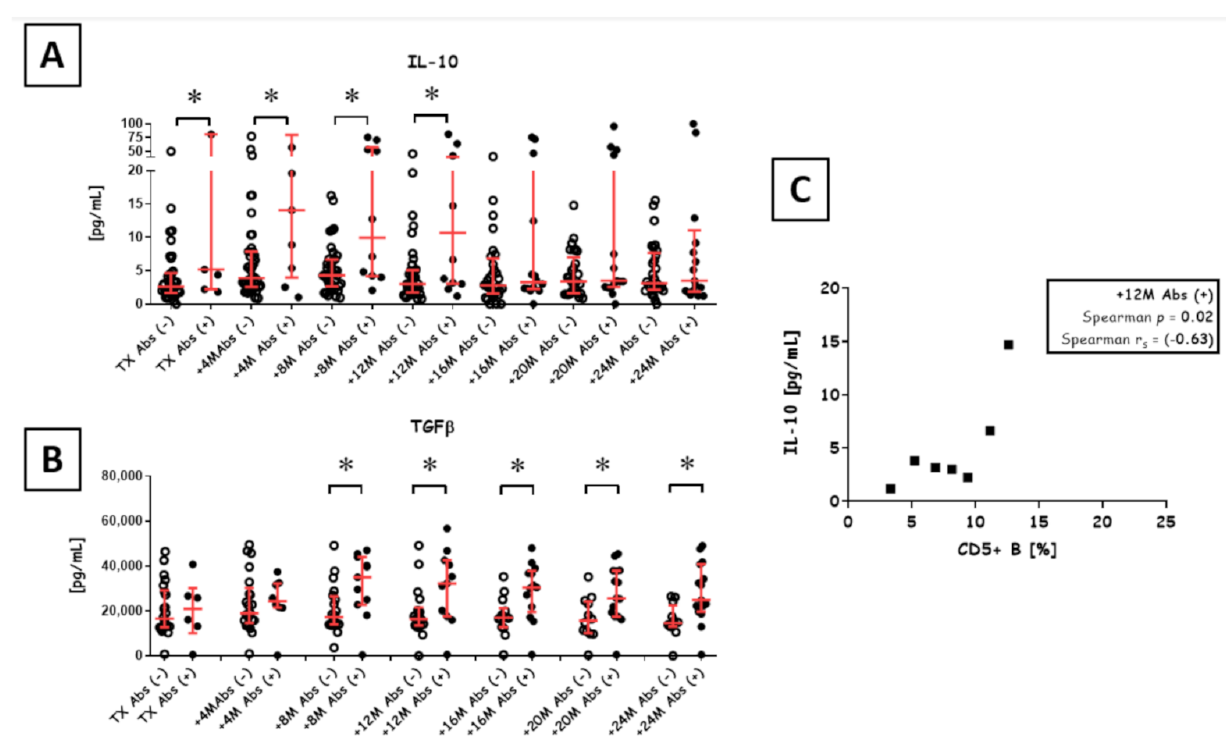
Figure 3. Anti-inflammatory cytokines during the first 2 y post-transplant. Serum IL-10 ( A ) and TGF β ( B ) levels in Abs- (open circles) and Abs+ (black circles) were compared for each measured time point across 52 patients. * p < 0.05 based on Mann-Whitney U tests. A correlation between IL-10 and CD5+ B cells among Abs+ patients at 12 months post-transplant ( C ). The ratio of Abs − to Abs+ recipients at measured time points was as follows: transplant (45/7), +4 months (42/9), +8 months (40/12), +12 months (37/14), +16 months (35/15), +20 months (33/17) and +24 months